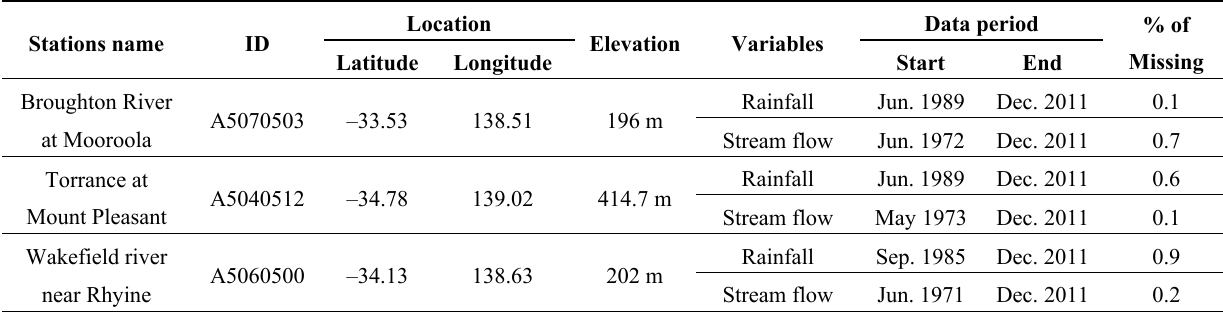
Table 1. Weather stations information, data quality and